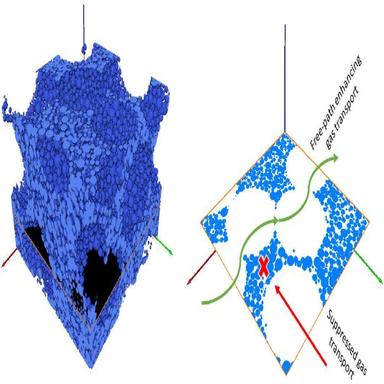
Spatial arrangement and connectivity of the large pores influence the permeability of the materials.